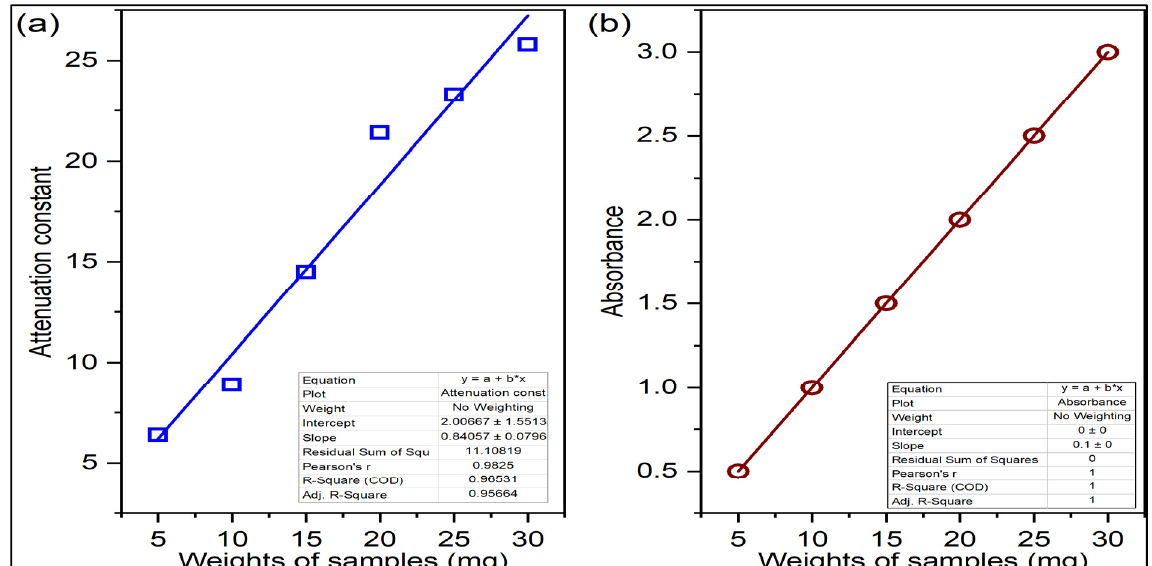
Table 1. Attenuation constant for wheat flours for different weights of samples.